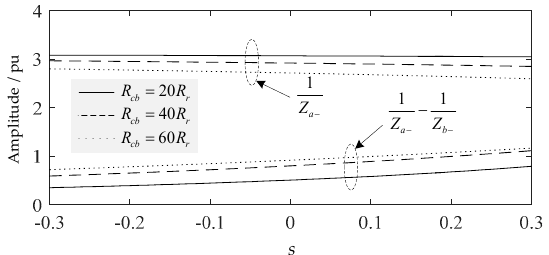
Figure 3. Amplitude relationship between 1 /